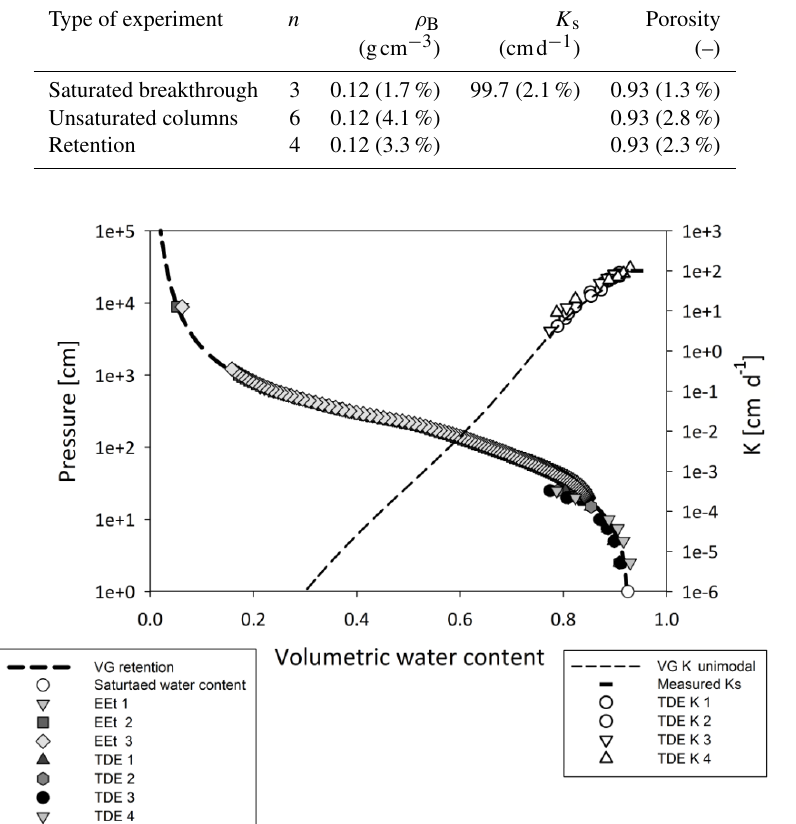
Figure 3. Soil water retention and hydraulic conductivity curves with measurement results of the transient evaporation experiments (EEts) and tension disk experiments (TDEs) and parameterizations for the unimodal van Genuchten–Mualem model. Negative pressure was used for the retention